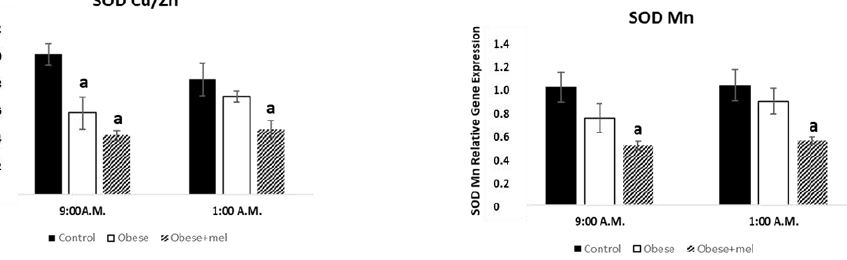
Figure 2. Relative gene expression of SOD Cu/Zn and SOD Mn enzymes in subcutaneous ( A ) and perirenal ( B ) adipose tissue of male Wistar rats at two different schedules (09:00 a.m. and 01:00 a.m.). Each value represents the mean and s.e.m. (n = 5). The letter indicates significant differences between diets (control or high fat diet) at the same schedule ( a p <0.05 vs. control; b p < 0.001 vs. obese group of animals) and the asterisk (* p < 0.05) indicates significant differences between schedules in each experimental group.